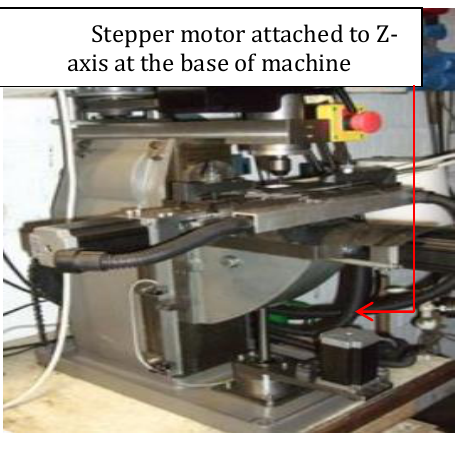
Source : MicroKinetics Corporation (2020) Figure 5: Linear Actuator to knee based Z-axis movement